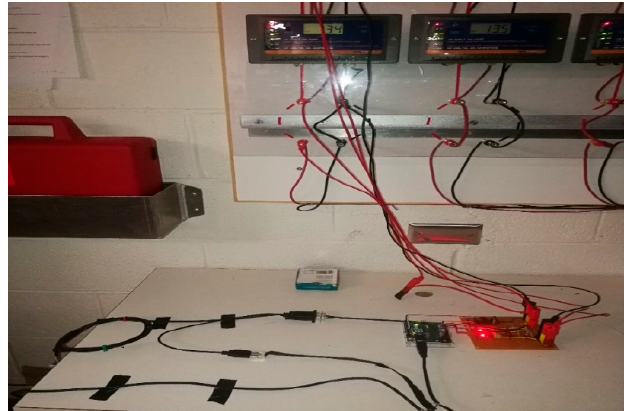
Figure 2. Lab setup of data logging system.